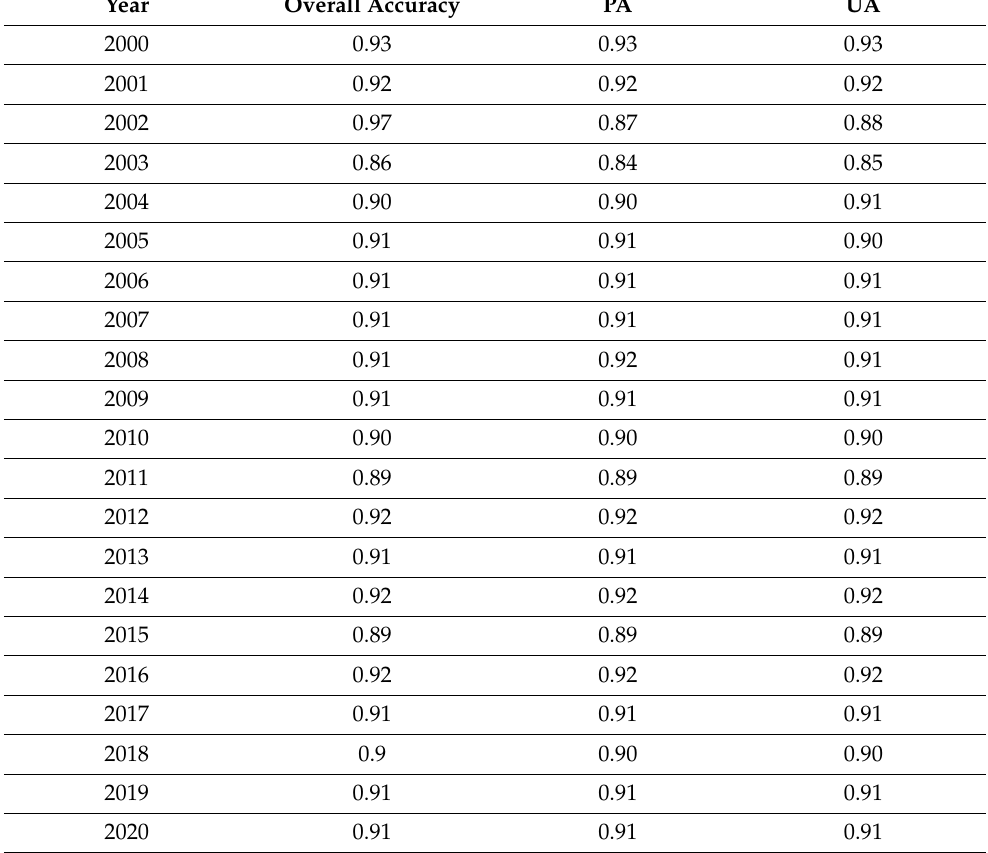
Table 2. Accuracy assessment of different land use/land cover data sets from 2000 to